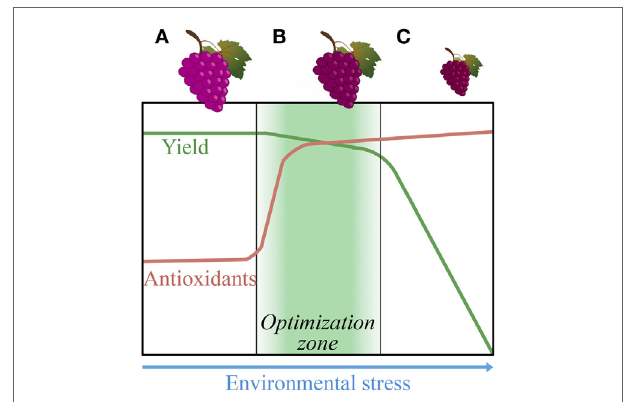
FiguRe 5 | Schematic depiction of the effect of environmental stress, such as decreasing water availability in the soil, on plant antioxidant content and crop biomass accumulation/yield . The grape berry bunches across the top symbolize the effect of (a) ample irrigation, (b) limited irrigation, and (C) severe drought. The shaded area under (b) represents the area of co-optimization for the combination of optimal antioxidant content combined with optimal crop yield. The depicted relationships are only intended to highlight the concept and specifics (starting levels of antioxidants and degree of increase in response to stress) should be expected to vary among plant organs (leaves, fruit, seed) and by antioxidant